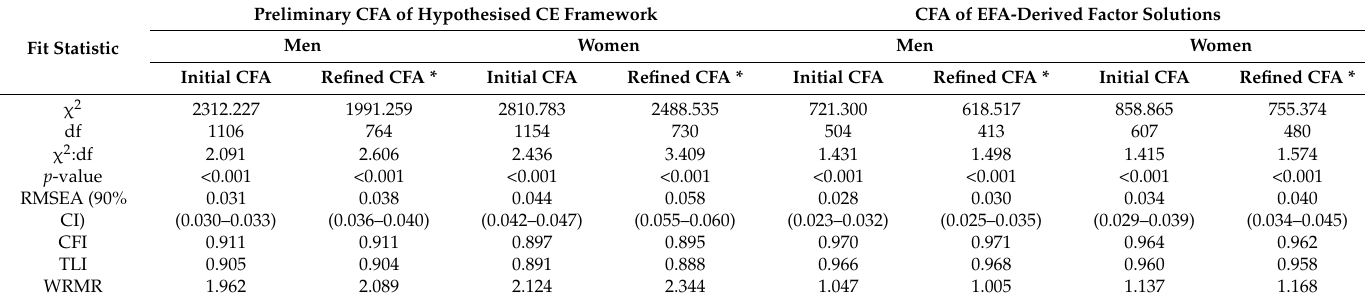
Table A4. Comparison of Model Fit Statistics from Preliminary CFA of Our Hypothesised CE Framework and CFA of EFA-Derived CE Factor Solutions. Preliminary CFA of Hypothesised CE Framework CFA of EFA-Derived Factor Solutions Men Fit Statistic